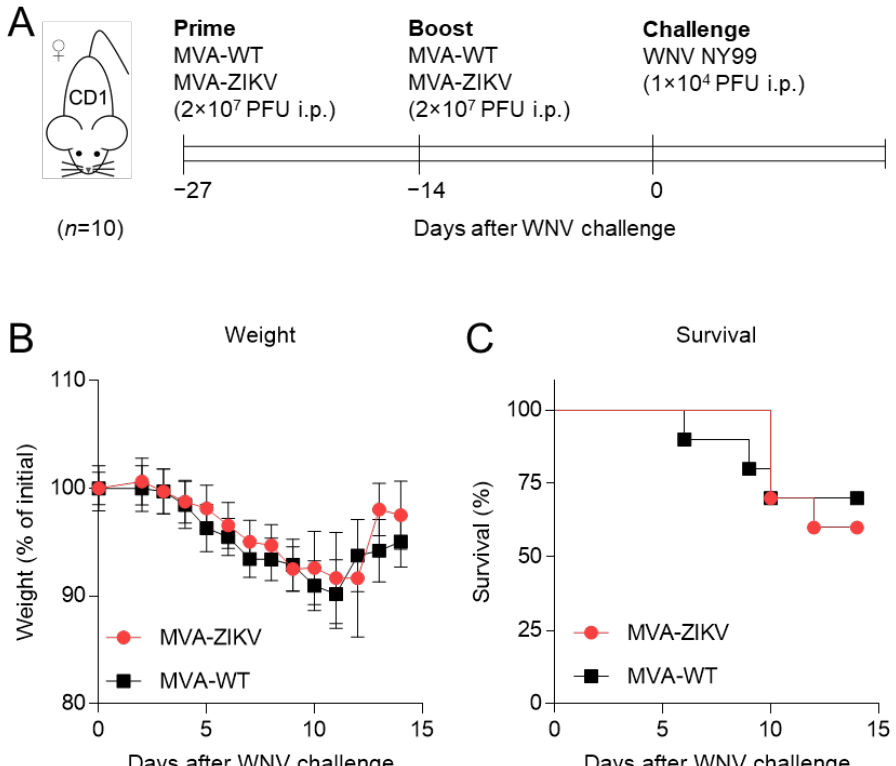
Figure 1. Experimental design, body weight loss, and survival analysis. ( A ) Experimental design. Four-week old CD1 female mice ( n = 10/group) were vaccinated with two doses of MVA-ZIKV encoding ZIKV prM and E proteins, or with MVA-WT as a control, at days 0 and 13 and challenged with WNV 27 days after the first immunization. Animals were monitored for body weight and survival after WNV challenge, and surviving animals were euthanized 14 days after challenge. ( B ) Body weight loss upon WNV infection. Data are presented as mean ± SEM. ( C ) Kaplan–Meier survival